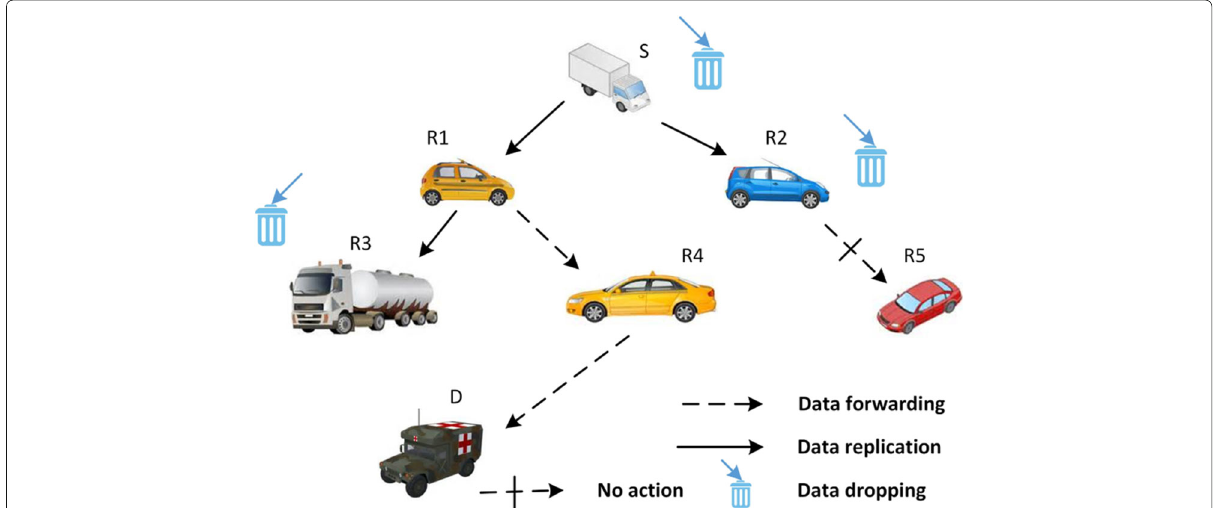
Fig. 2 An example to show multi-copy forwarding in the vehicular sensor